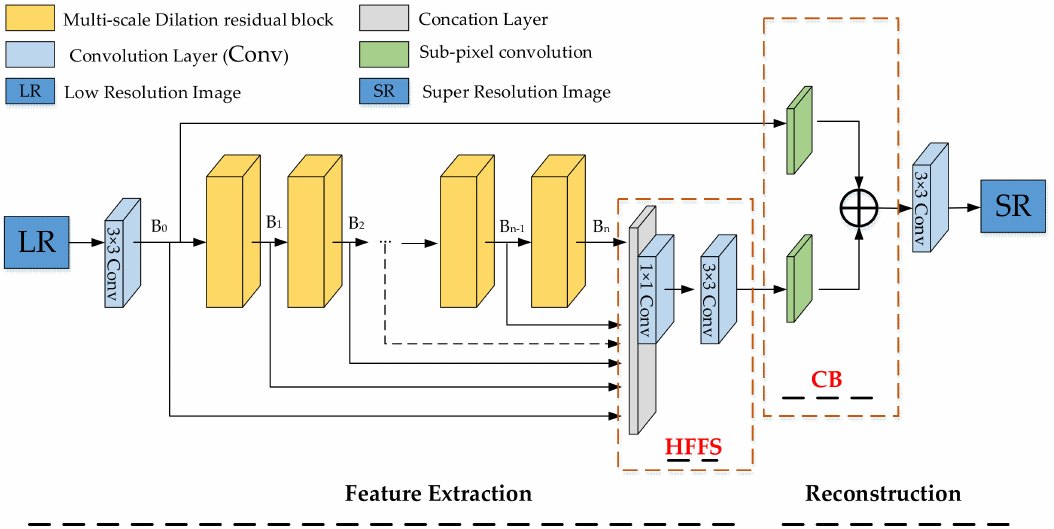
Figure 1. Pyramidal multi-scale residual network (PMSRN) model architecture. The network model includes two parts: feature extraction and reconstruction. Feature extraction is performed by the hierarchical feature fusion structure (HFFS) and eight multi-scale dilation residual blocks (MSDRBs), and reconstruction mainly involves a complementary block